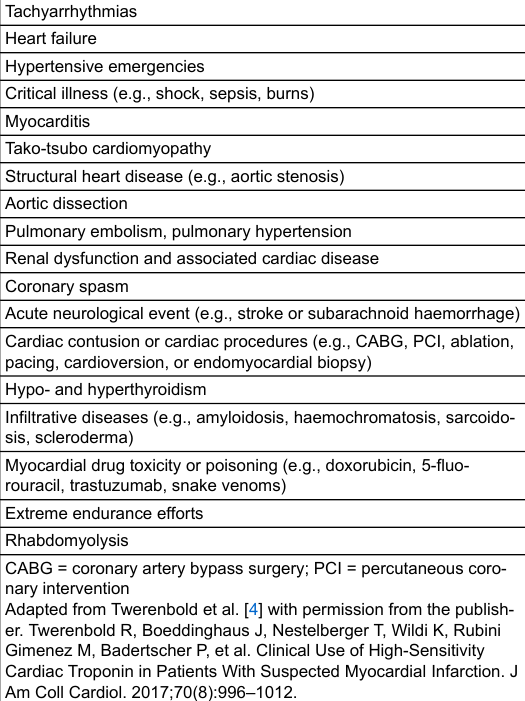
Table 1: Conditions other than myocardial infarction associated with cardiac troponin elevations.